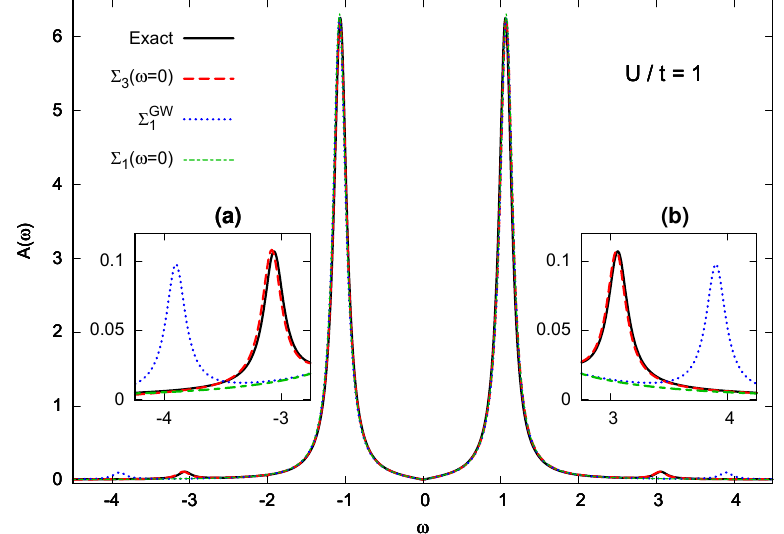
Figure 4: The spectral function of the Hubbard dimer at 1/2 filling at weak in- teraction ( U / t = 1 ) obtained with various levels of theory. Exact result (black solid line); the 1-GF obtained from the exact static 3-SE (red dashed line); the GW approximation (blue dotted line); the exact static 1-GF (green dashed line). The outer peaks are the satellites. (a) zoom of the removal satellite; (b) zoom of = − U / 2 which guarantees the the addition satellite. The spectra correspond to ε 0 particle-hole symmetry.